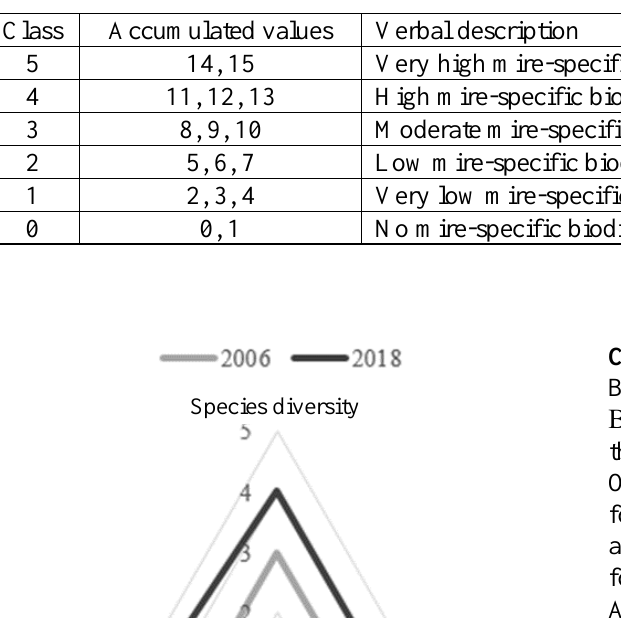
Table 11. Overall assessment of mire-specific biodiversity based on the accumulated indicator values for species, biocoenosis and ecosystem levels.